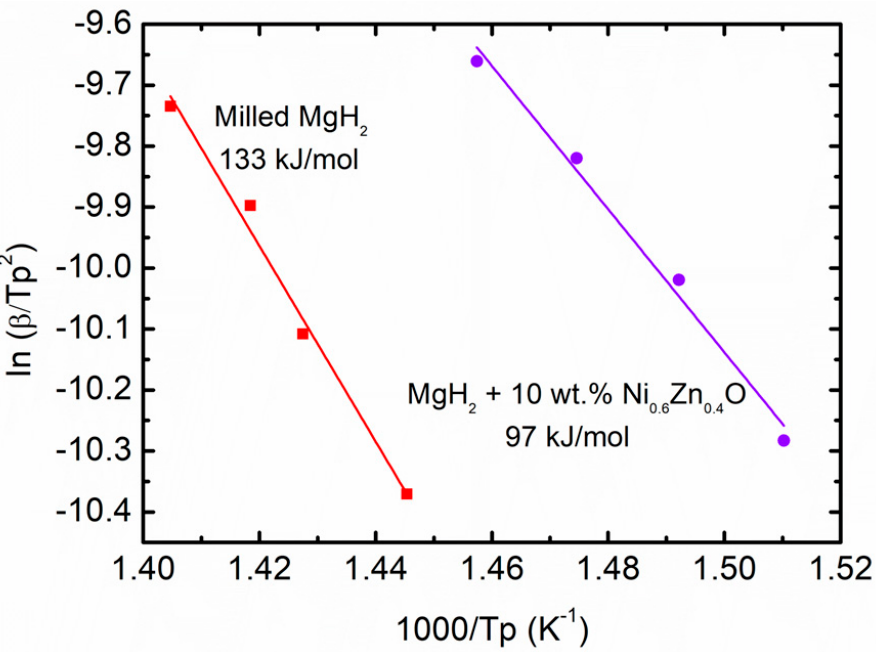
Figure 6. Activation energy for milled MgH 2 and MgH 2 –10 wt.% Ni 0.6 Zn 0.4 O samples.